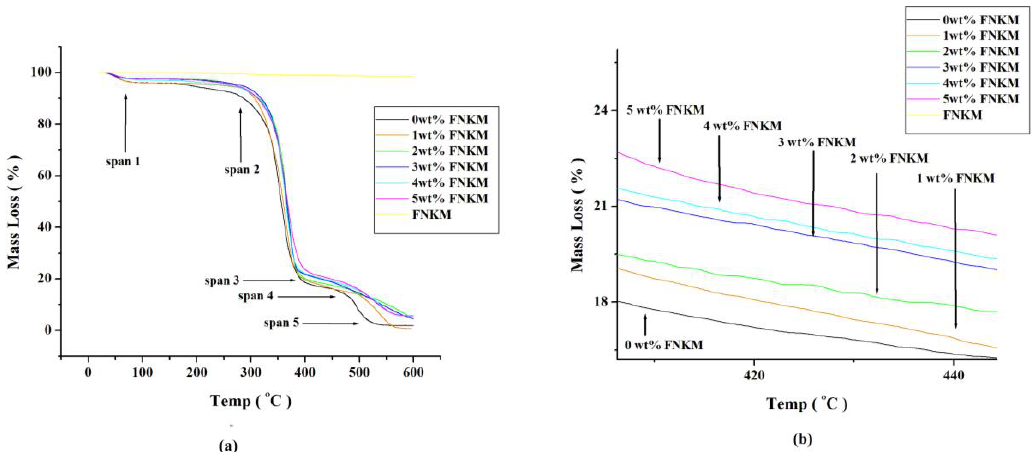
Figure 4. Thermo-gravimetric analyzer (TGA) curves of ( a ) FNKM and 0–5 wt % FNKM loaded CA membranes; ( b ) magnified image of span 4 at temperature rising rate of 10 °C/min in oxygen environment.